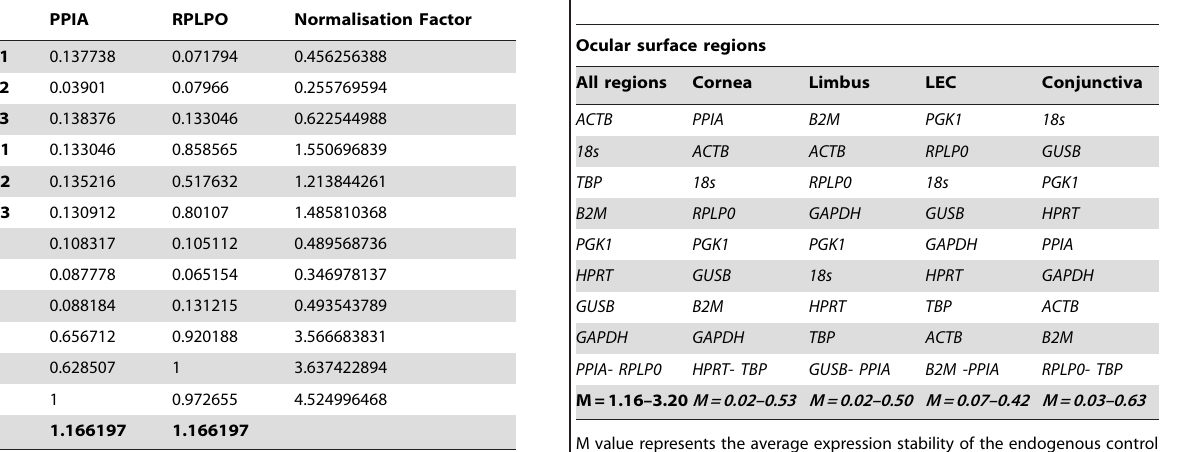
Table 4. Ranking of the endogenous control genes with increasing stability in descending order in ocular surface regions.